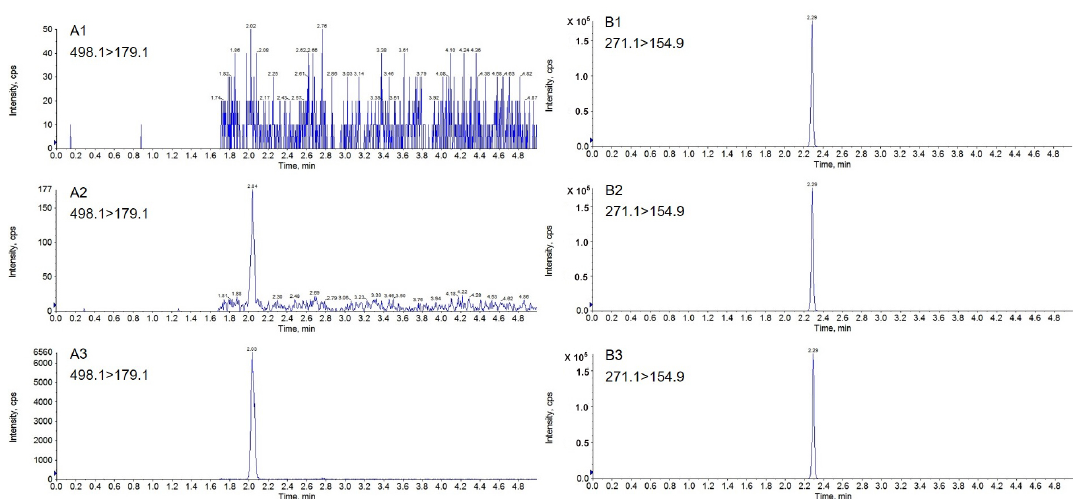
Figure 3. Typical chromatograms of PF ( A1 – A3 ) and IS ( B1 – B3 ) for (1) double blank plasma sample, (2) extracted plasma sample at lower limits of quantification (LLOQ) and (3) extracted plasma at 0.25 h after mono-administration of PF.